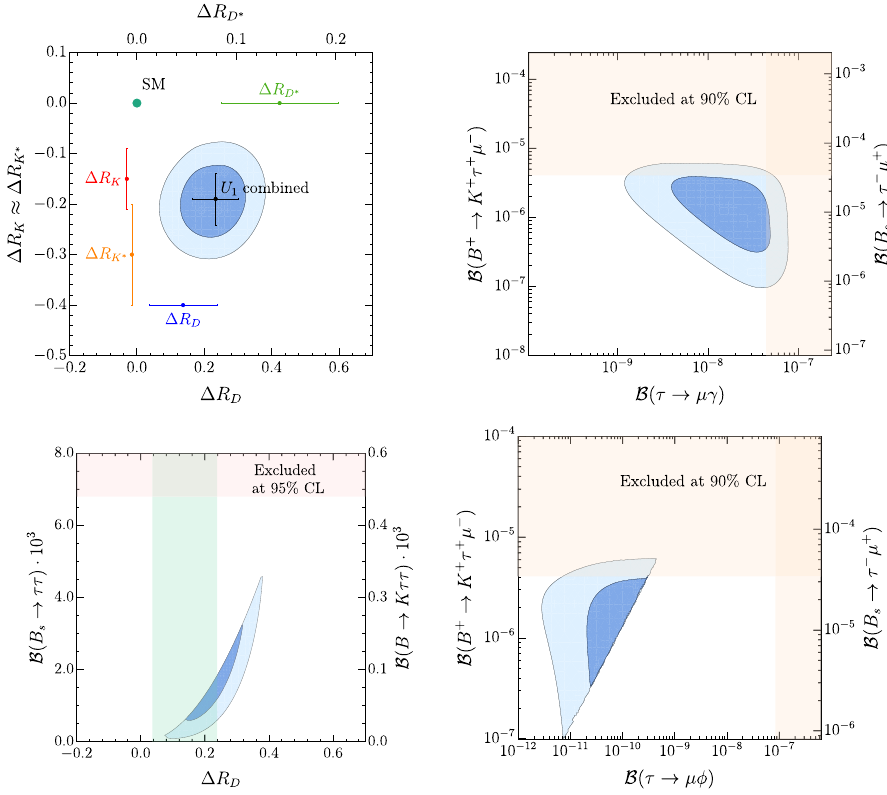
Figure 3 . Preferred 2D fit regions for different experimental observables, marginalizing over the 2 . 30 (1 σ ) and ∆ χ 2 6 . 18 (2 σ ) regions are shown in blue and rest of parameters. The ∆ χ 2 ≤ ≤ light blue, respectively. The intervals in the top left plot show the current experimental measure- ments of ∆ R and ∆ R with 1 σ errors. The cross corresponds to the combination of these K ( ∗ ) D ( ∗ ) measurements assuming the relation among these observables in our U 1 model. The red (orange) bands show the 95% (90%) CL experimental exclusion limits, while the green band indicates the experimental measurement at 1 σ